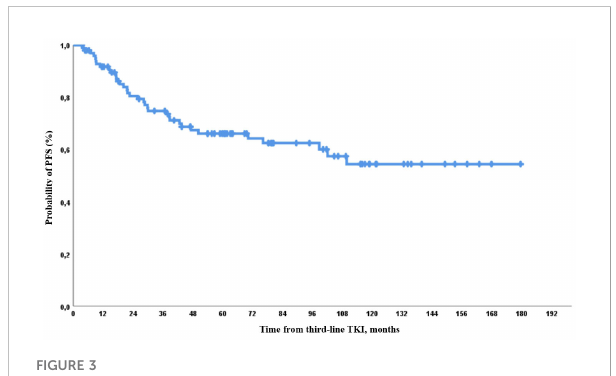
FIGURE 3 Progression-free survival (PFS) on third-line TKI therapy.